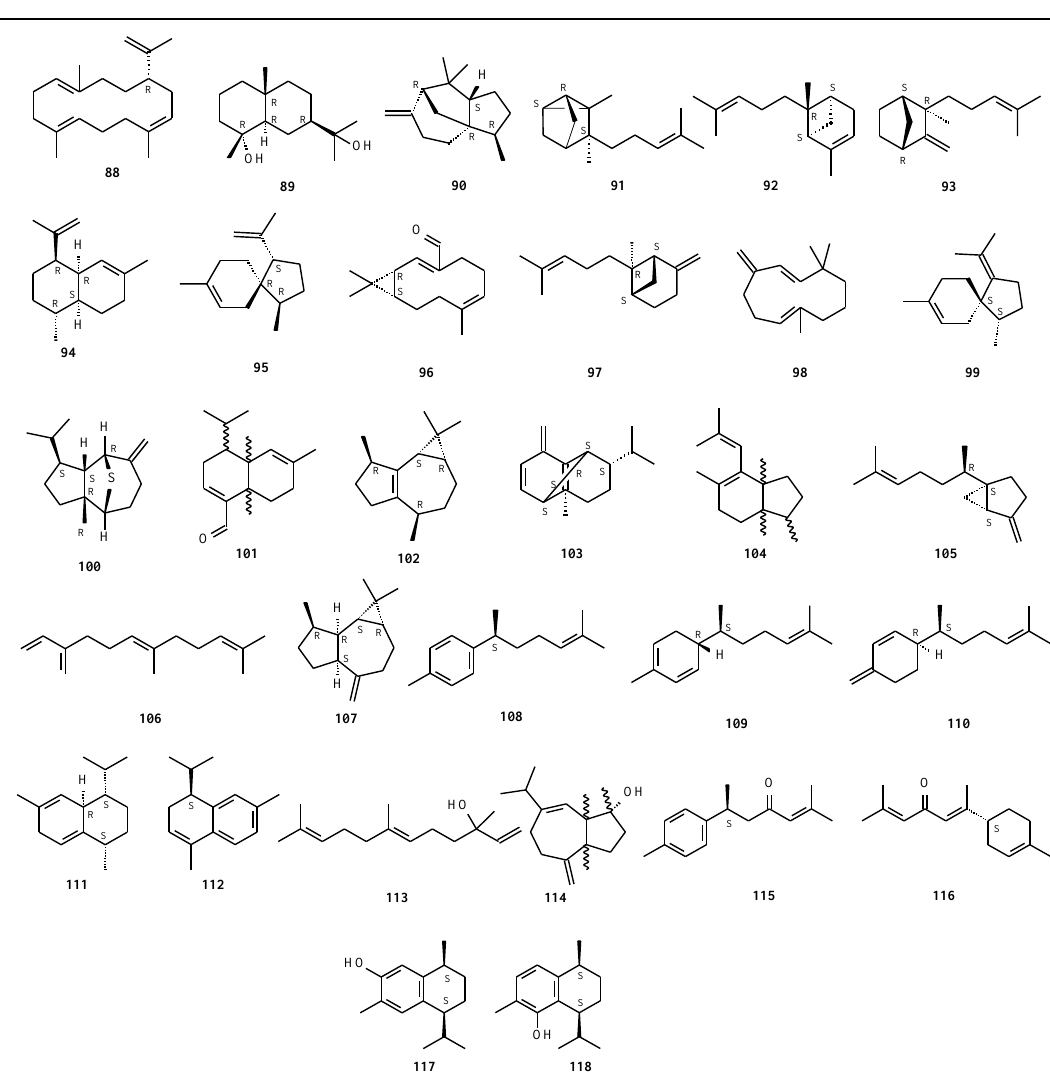
Table 6. Triterpenes isolated from the genus Cedrela